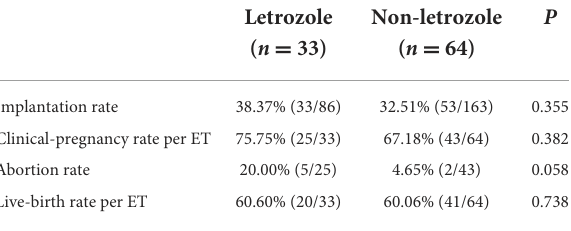
TABLE 3 Reproductive outcomes of fresh-embryo transfer cycles in the study group.